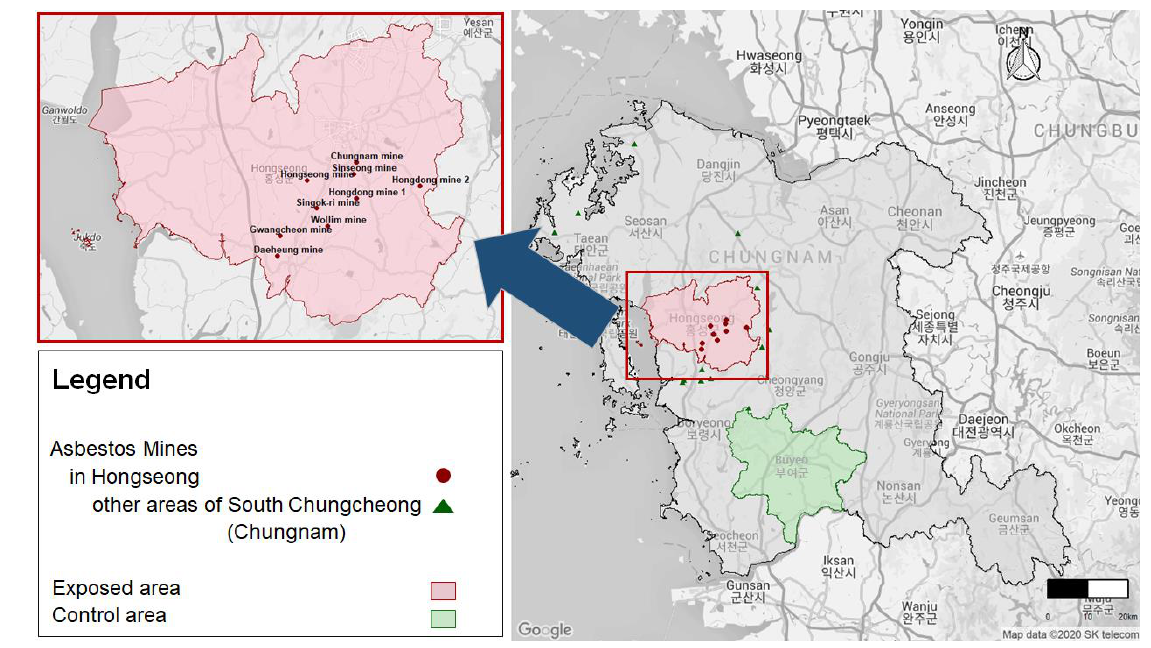
Figure 1. Exposed and control areas.